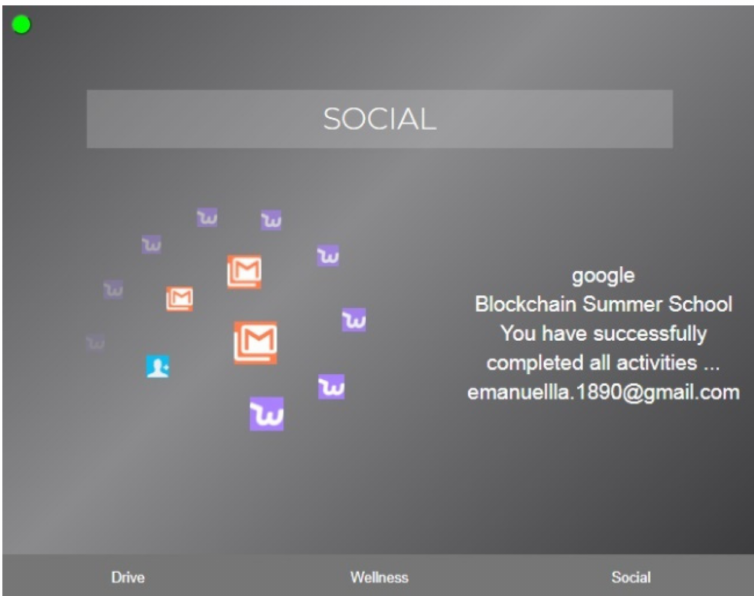
Figure 6. The Social panel